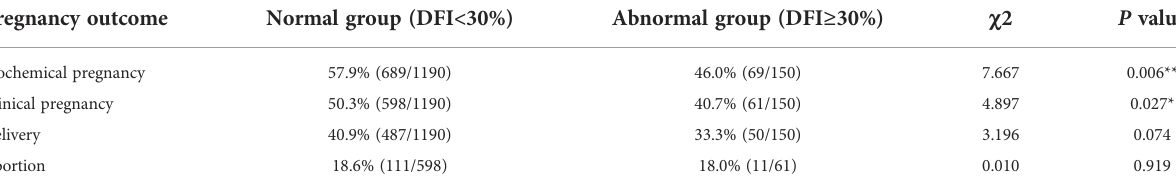
TABLE 5 Comparison of pregnancy outcome rates between normal and abnormal sperm DFI in frozen embryo transfer cycles. Pregnancy